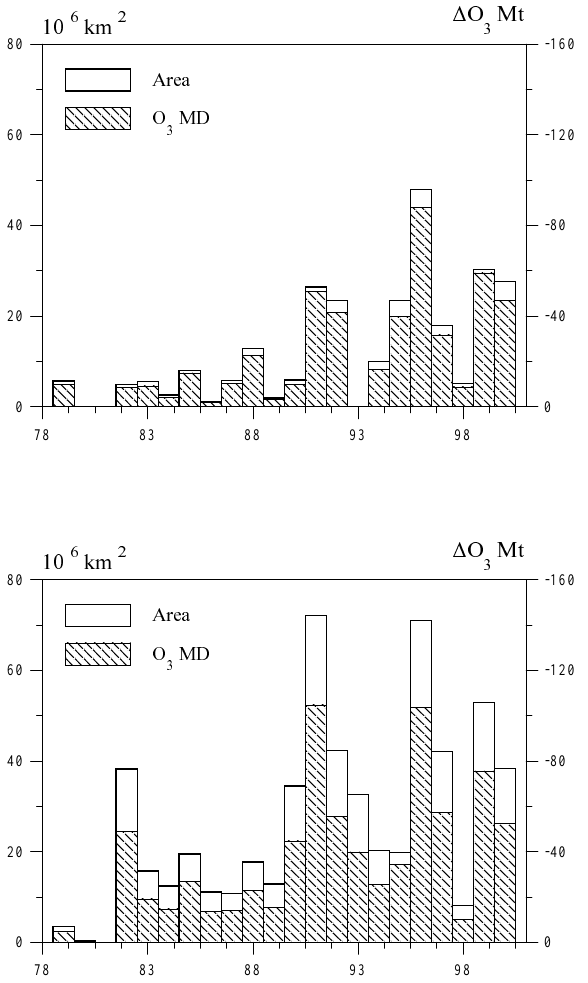
Fig. 8. Integrated area (106 km 2 ) and the corresponding integrated Ozone Mass Deficiency (O 3 MD) during the 1979–2000 period. Panel (a) the ELO 3 episodes with “ (cid:127) < 220 matm-cm” over the North Atlantic/European region of the 40–65 ◦ N belt; Panel (b) the cases when negative total ozone deviation of the pre-1976 averages was > 25% over the same